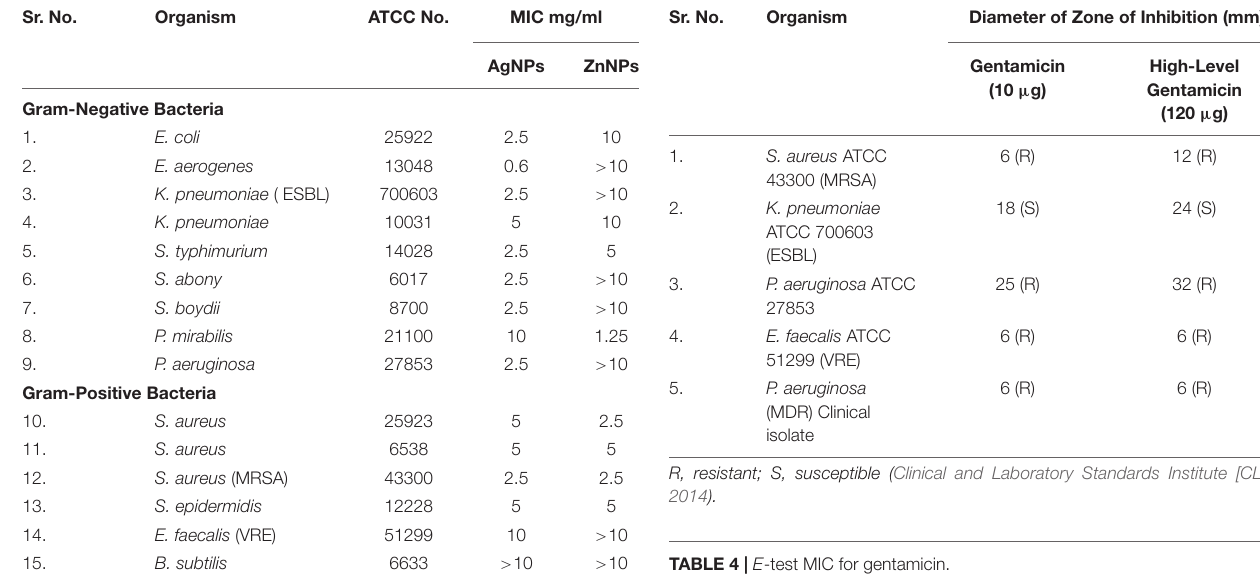
TABLE 3 | Susceptibility for gentamicin.